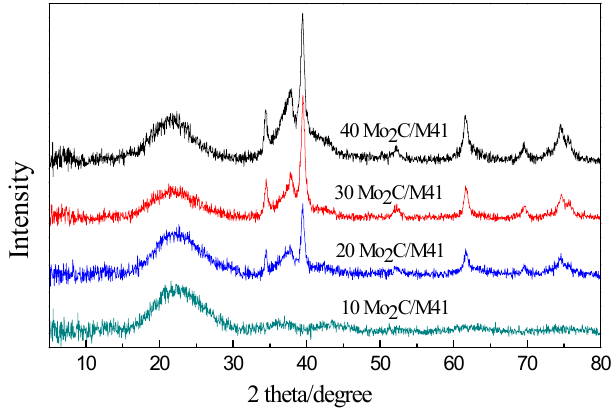
Figure 1. X-ray diffraction (XRD) patterns of the y Mo 2 C/M41 samples. Figure 1 . X ‐ ray diffraction (XRD) patterns of the y Mo 2 C/M41 samples. Figure 1 . X ‐ ray diffraction (XRD) patterns of the y Mo 2 C/M41 samples.